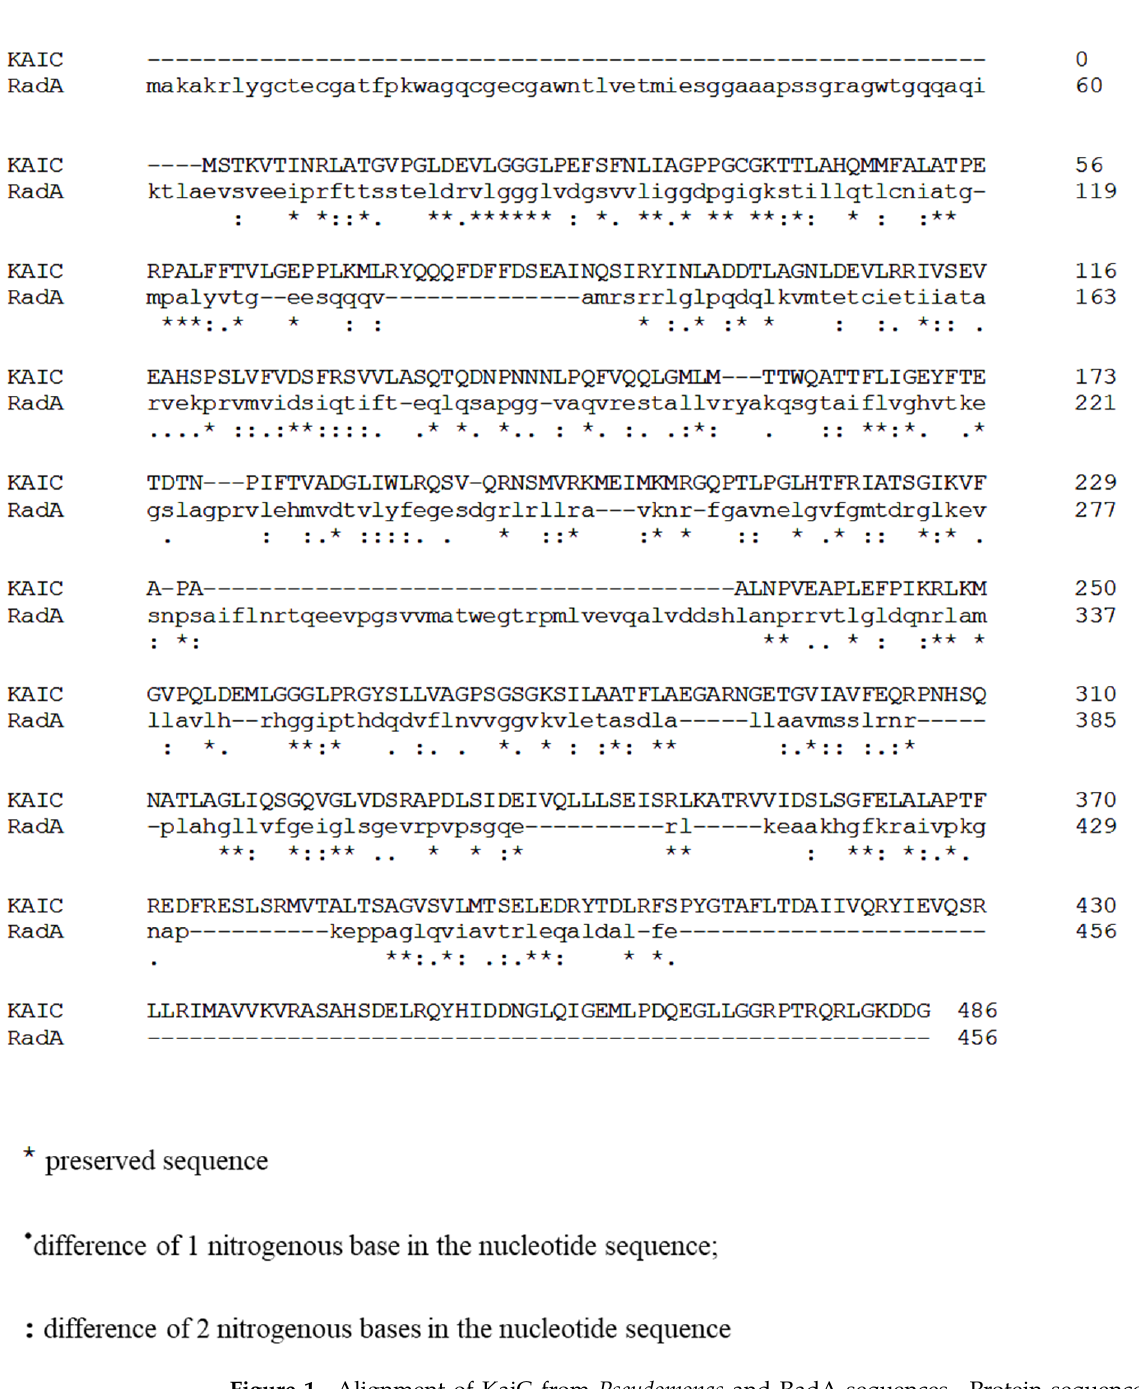
Figure 1. Alignment of KaiC from Pseudomonas and RadA sequences. Protein sequence of the circadian clock protein KaiC from Pseudomonas sp. 460 were extracted from the Uniprot site, and a position-specific iterative (PSI) basic local alignment search tool (BLAST) was used to realize protein sequence against the proteome of Escherichia coli targeting non-redundant protein sequences. The alignment of KaiC and RadA was generated using Clustal Omega (the star represents preserved sequences; one point represents a difference of 1 nitrogenous base in the nucleotide sequence and deux points represents a difference of 2 nitrogenous bases in the nucleotide sequence).